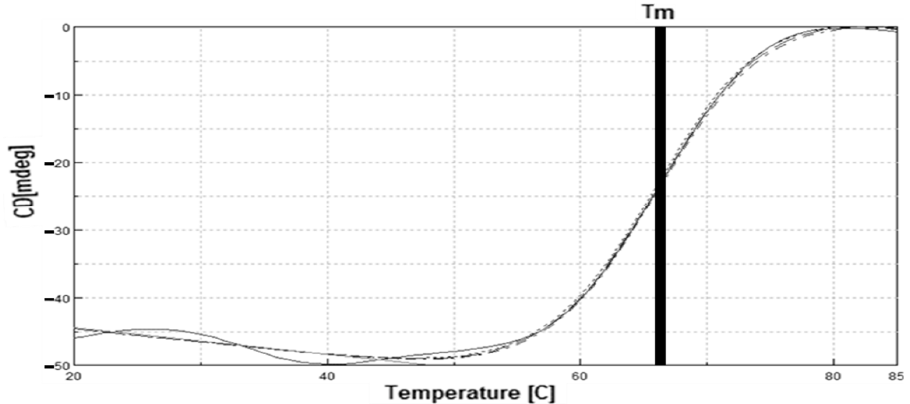
Figure 11. Tm (Melting temperature) analysis of LIP2. The thick vertical line in the middle indi- cates the melting point value of LIP2 when tested within the temperature range of 20–85